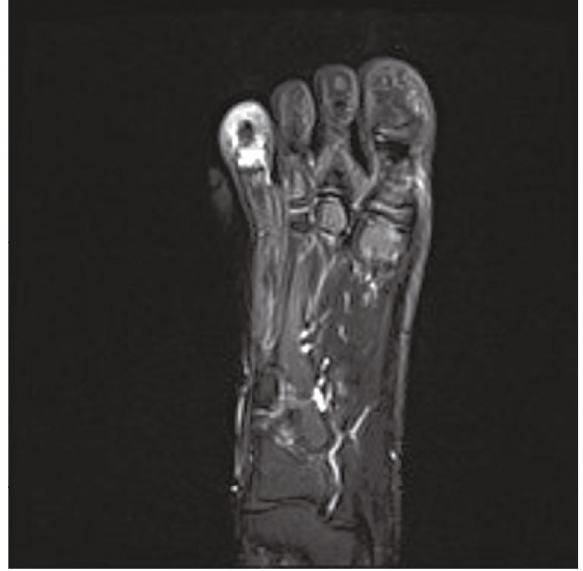
Figure 2: T2-weighted image on MRI, showing the sclerotic nidus hyposignal and the surrounding in fl ammation of the soft tissues around (hypersignal).